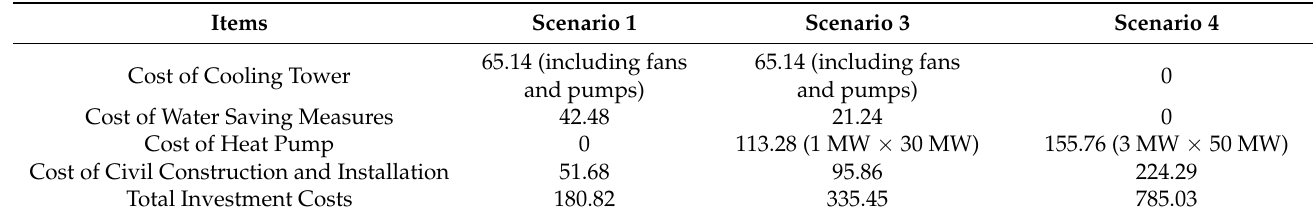
Table 4. Comparison of investment costs (unit: million USD).